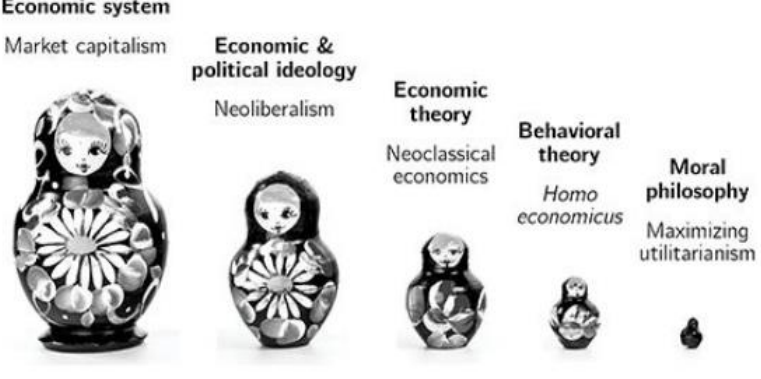
Figure 1. Beinhocker's imagined economic order